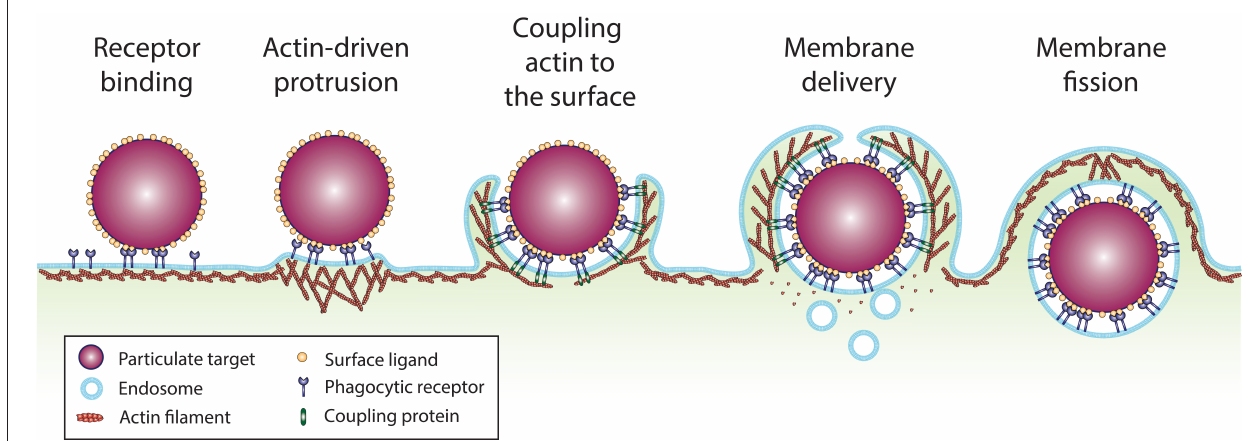
FIGURE 2 | Sequence of events involved in particle uptake by phagocytosis. (1) Phagocytic receptors (dark blue) diffuse along the plane of the plasma membrane and bind ligands (yellow) at the surface of the particulate target (purple). (2) Ligand binding and clustering of the receptors elicits signaling that activates actin polymerization, which generate a protrusive force against the plasma membrane. (3) Anchorage of the actin cytoskeleton to ligand-bound receptors on the particle surface by coupling or tethering proteins, tangentially to the direction of actin polymerization, enables membrane protrusions to extend over the particle surface. (4) For large particulate targets, mobilization of membrane reservoirs from surface folds of the plasma membrane and intracellular vesicles provides the required membrane surface area to envelop the particle. (5) Once the particle is fully enveloped and the protrusions reach a meeting point, membrane fission enables the separation of the phagosome from the plasma